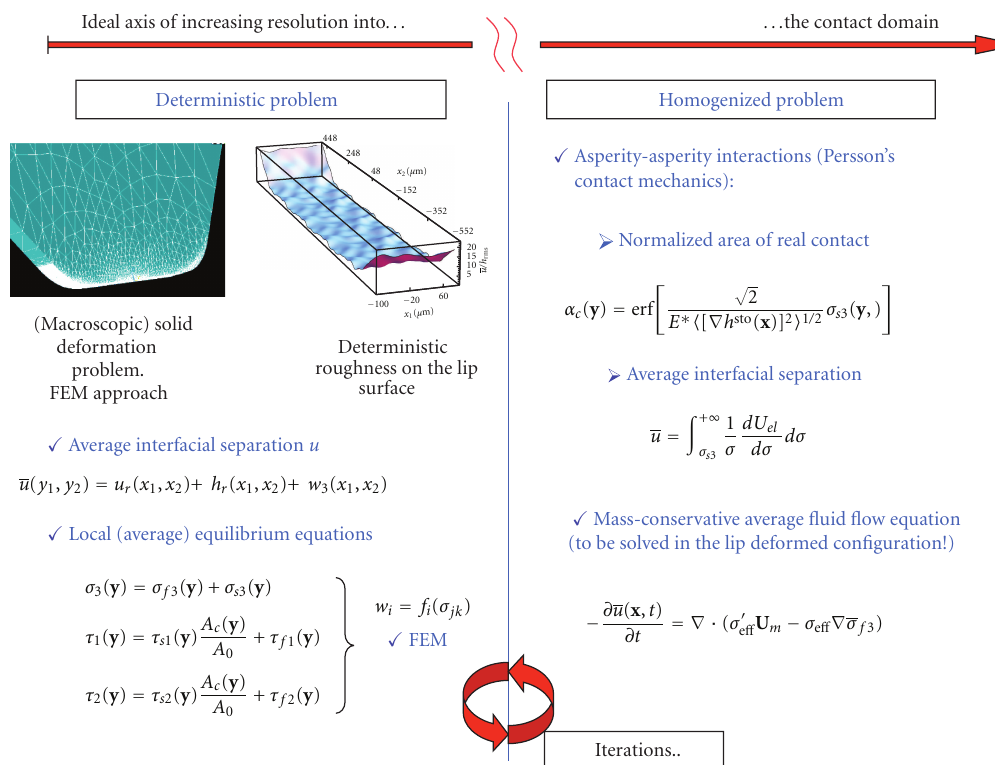
Figure 13: Algorithm scheme. In the two-scales approach, the solution of the contact problem is split into two, coupled problems, respectively, the deterministic and the homogenized problem. Those are solved iteratively towards convergence.